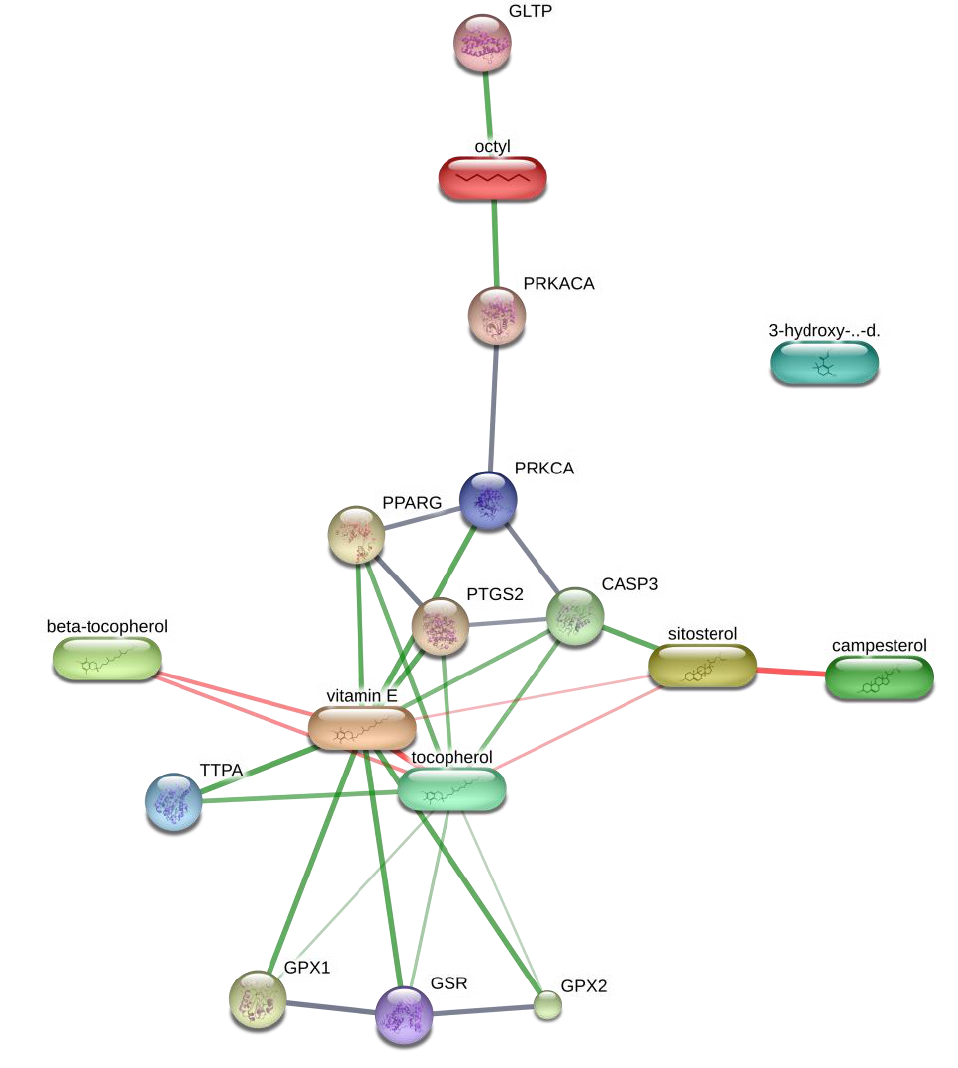
Figure 8. Network pharmacology presentation of phytoconstituents, targets, and pathways. Here, GLTP: Glycolipid transfer protein, PRKACA: Protein kinase CAMP-activated catalytic subunit alpha; PPARG: Peroxisome proliferator-activated receptor gamma; CASP3: Caspase 3; PTGS: Prostaglandin- endoperoxide synthase; TTPA: Alpha tocopherol transfer protein; GPx: Glutathione peroxidase; GSR: Glutathione-disulfide reductase; PRKCA: Protein kinase C-alpha. Table 6. Biological processes representation of the interacting